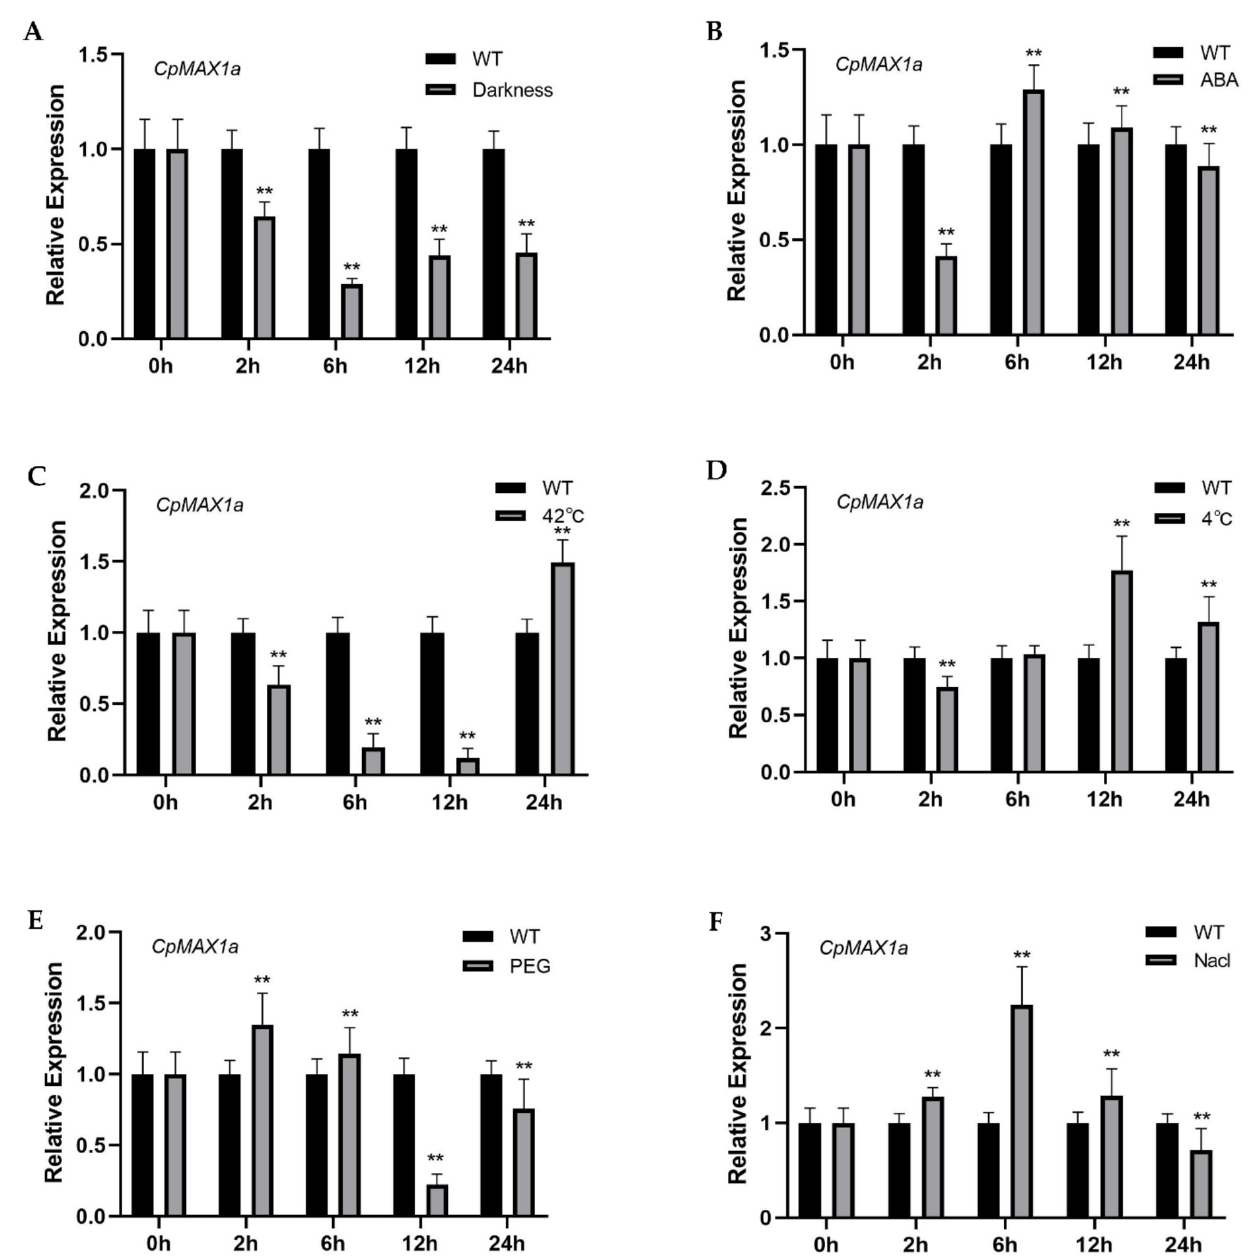
Figure 4. Effect of environmental factors on the expression of CpMAX1a . Six-leaf stage wintersweet was exposed to ( A ) Dark treatment, ( B ) 50 µ M ABA, ( C ) 42 ◦ C, ( D ) 4 ◦ C, ( E) 50% PEG-6000, and ( F ) 300 mM NaCl treatments. Data represent the mean of three biological repeats ± SD. Error bars indicate standard deviation. ** p <